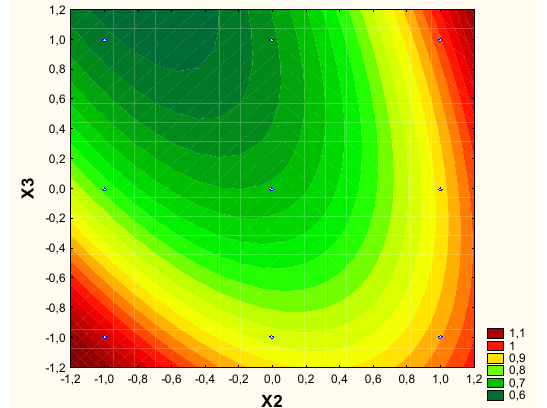
Figure 3. Interaction between concentration of glycerol and concentration of enhancer (X